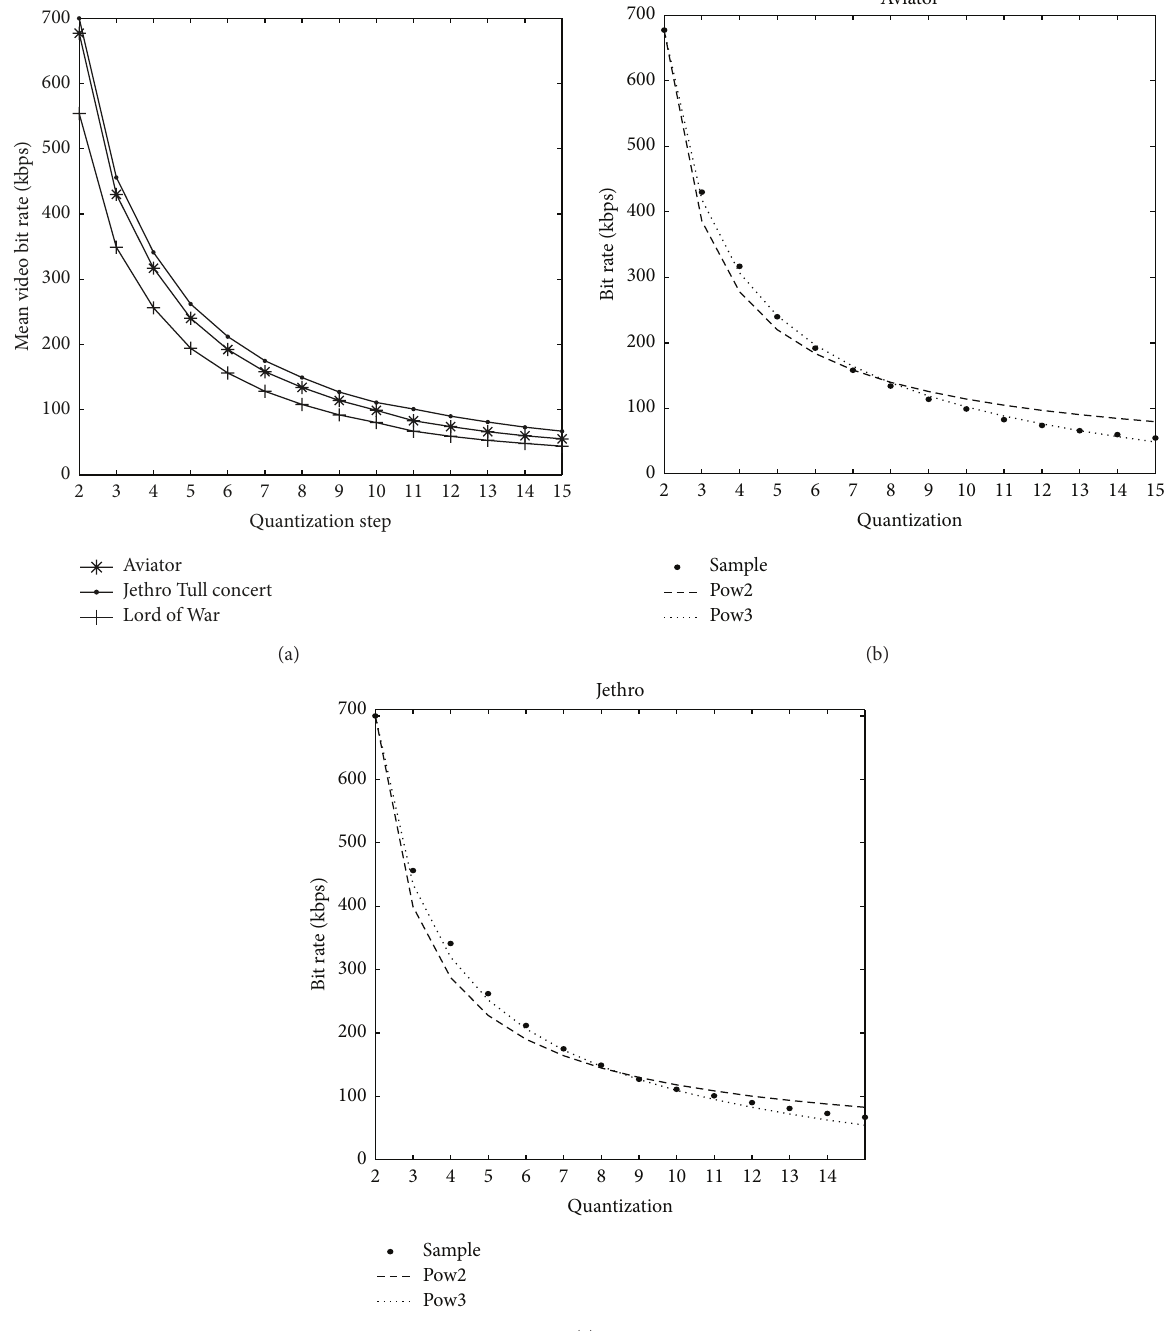
Figure 1: Mean video bit rate and